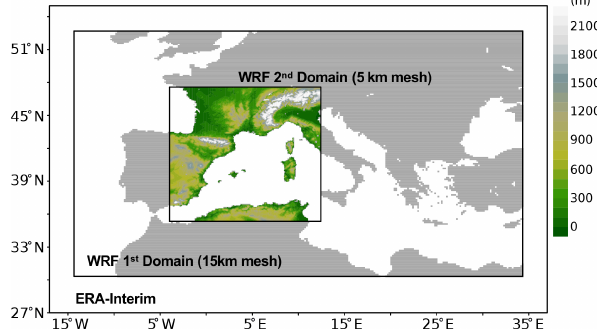
Figure 1. Domains for WRF simulations for medicane Rolf. Shad- ing in WRF second domain is topography height from